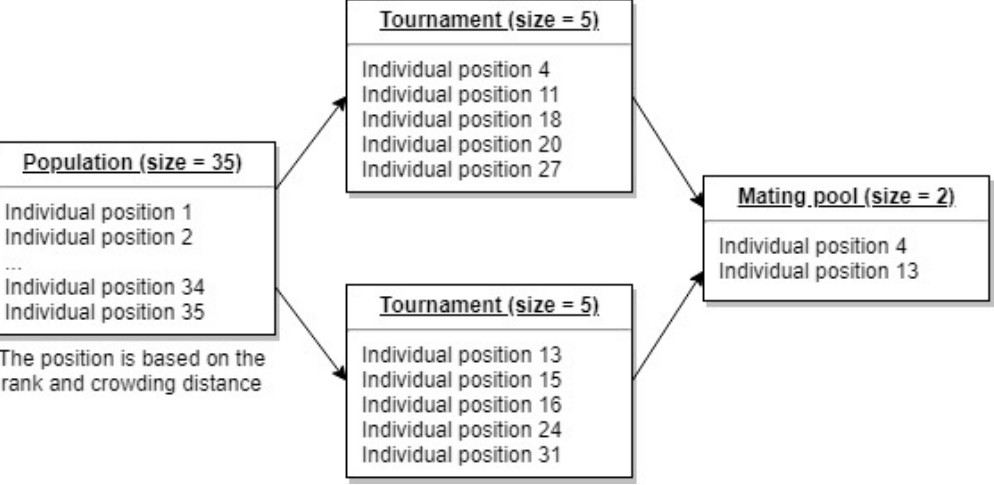
Figure 6. The tournament selection.